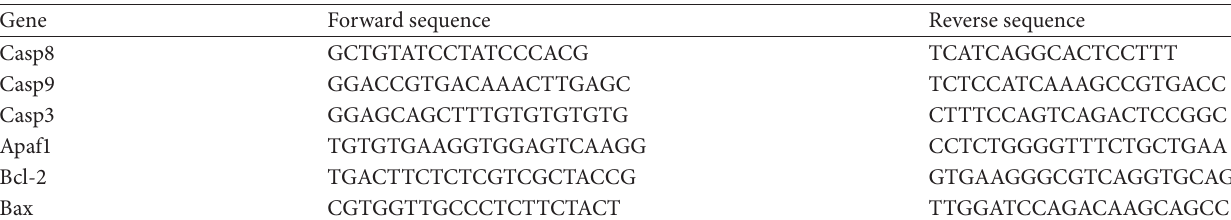
Table 1: PCR primer sequences used in the